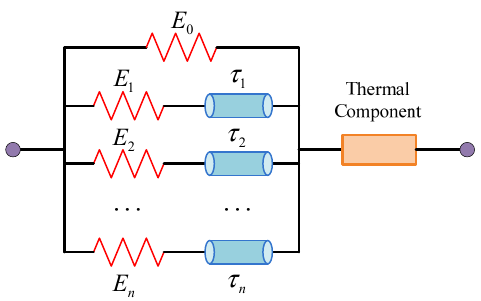
Figure 5. Generalized Maxwell model.